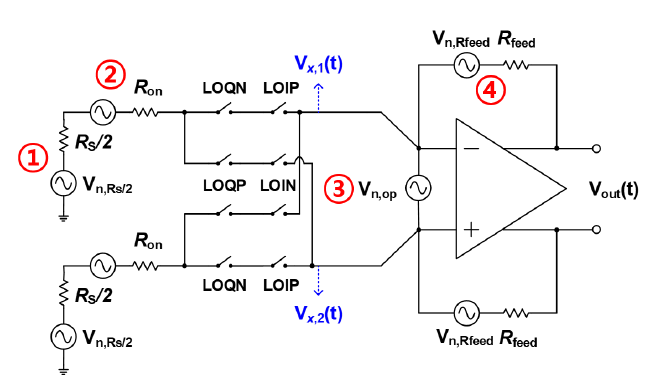
Figure 16. Equivalent noise analysis model of proposed mixer. NF is found using 4 noise sources ( 1 (cid:13) ∼ 4 (cid:13) ) represented as shown in Figure 17. As it can be 2 out 1 · 1 expressed as NF = V , V 2 out 1 and A 2 V , total are found using Equations (12) and (13). 4 kTR S A 2 V , total